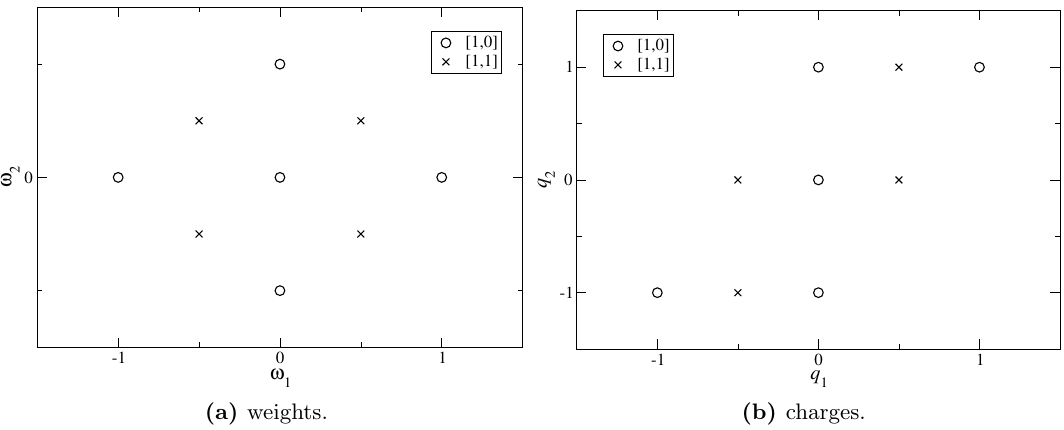
Figure 1 . Relationship between the weights (a) of the [1 ; 0] (Dynkin labels (1 ; 0)) and [1 ; 1] (Dynkin labels (0 ; 1)) representation of SO(5) and the charges (b) determined by (2.7) with the projection of the magnetic (cid:12)elds ~h = ( h 1 ; h 2 ) in (1.1) on the directions of the simple roots, H 1 = (cid:11) 1 (cid:1) ~h , H 2 = (cid:11) 2 (cid:1) ~h